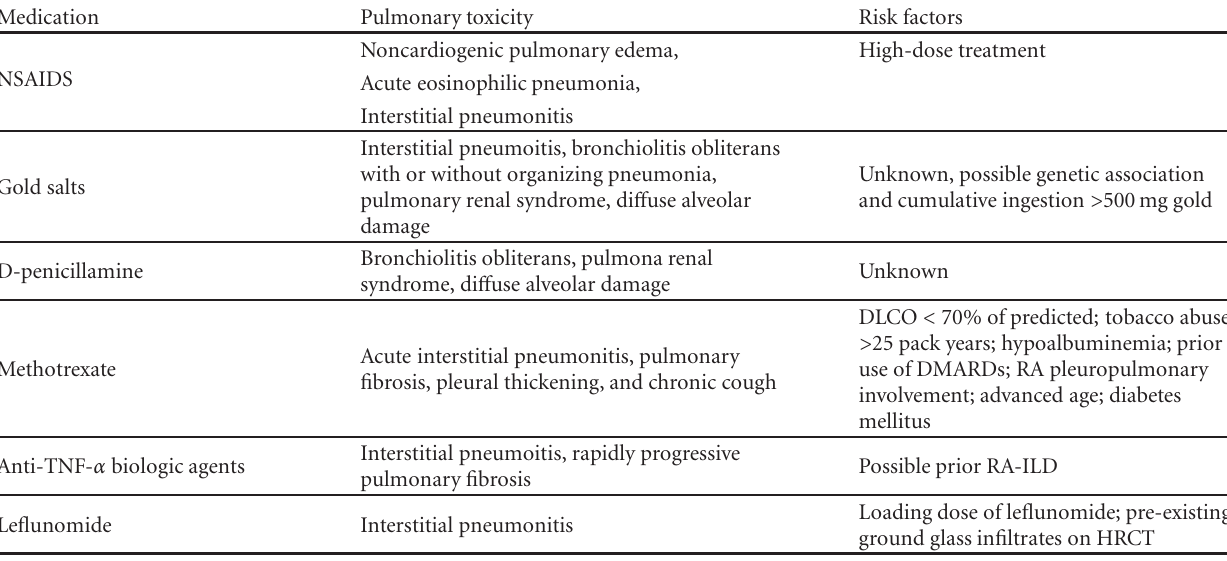
Table 2: Common pulmonary drug toxicities and associated risk factors associated with medications used to treat rheumatoid